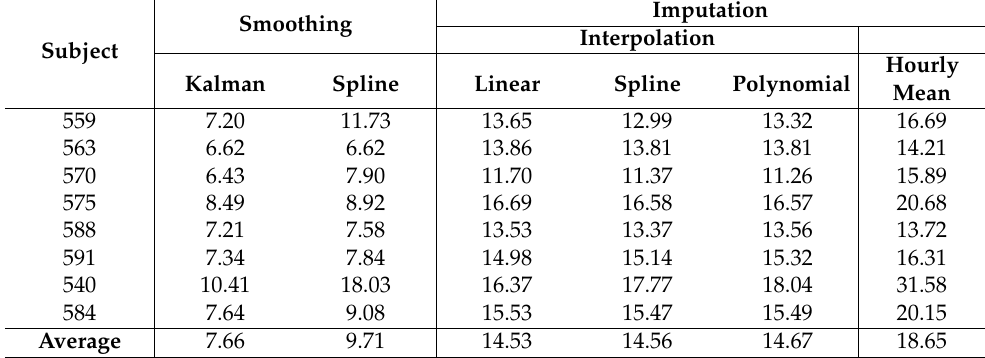
Table 7. Average RMSE for predicting glucose level using XGBoosting after imputation/smoothing.